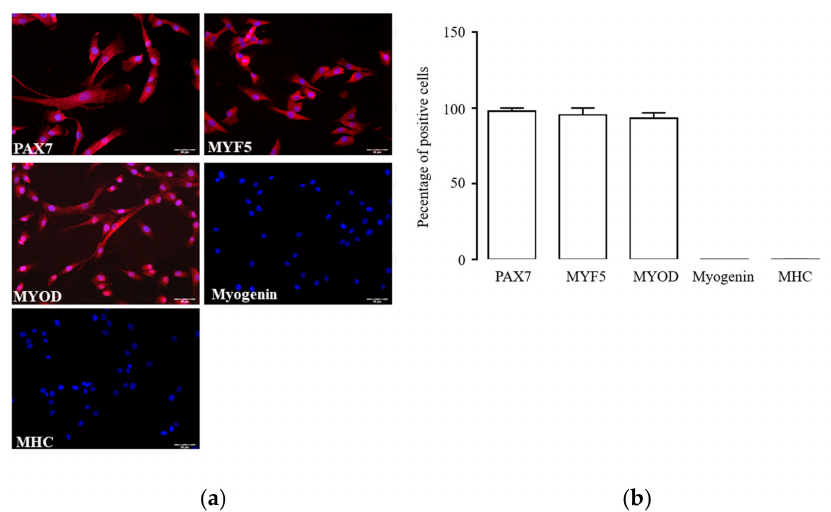
Figure 1. Phenotype of cultured human satellite cells (hSCs): immunolabelling ( a ) and percentage of positive cells ( b ) for Paired box protein 7 (PAX7), myogenic factor 5 (MYF5), myogenic factor 3 (MYOD), myogenin, and myosin heavy chain (MHC) in cultured hSCs at passage 3. Target proteins are depicted in red, and cell nuclei are in blue (DAPI). The image magnification is 20 × .